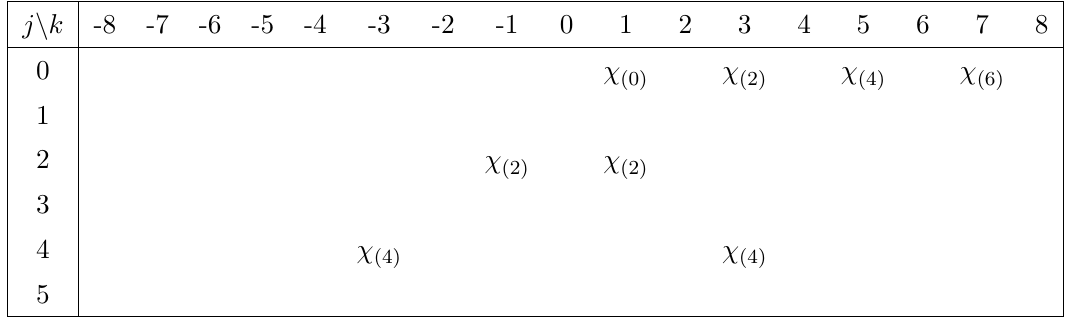
( m ) in the series expansion of (cid:24) 1 ; Sp(1) s , written in Sp(1) j;k = (cid:31) Sp(1) ( m ). ( n ) Sp(1) ( n )